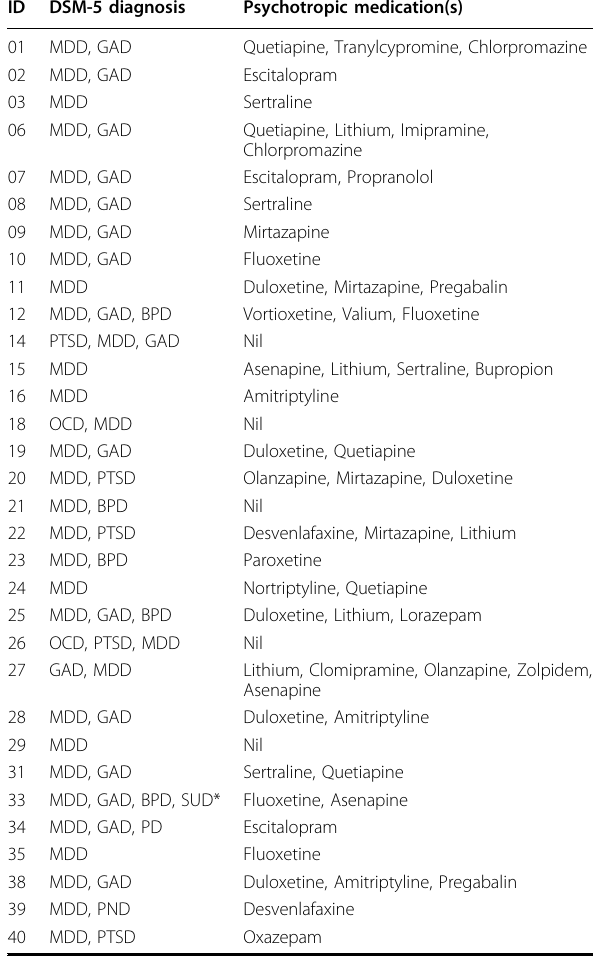
Table 1 DSM-5 diagnoses ( primary , comorbidity) in addition to ‘ chronic suicidality ’ and corresponding psychotropic medications concurrently taken at the time of the ketamine